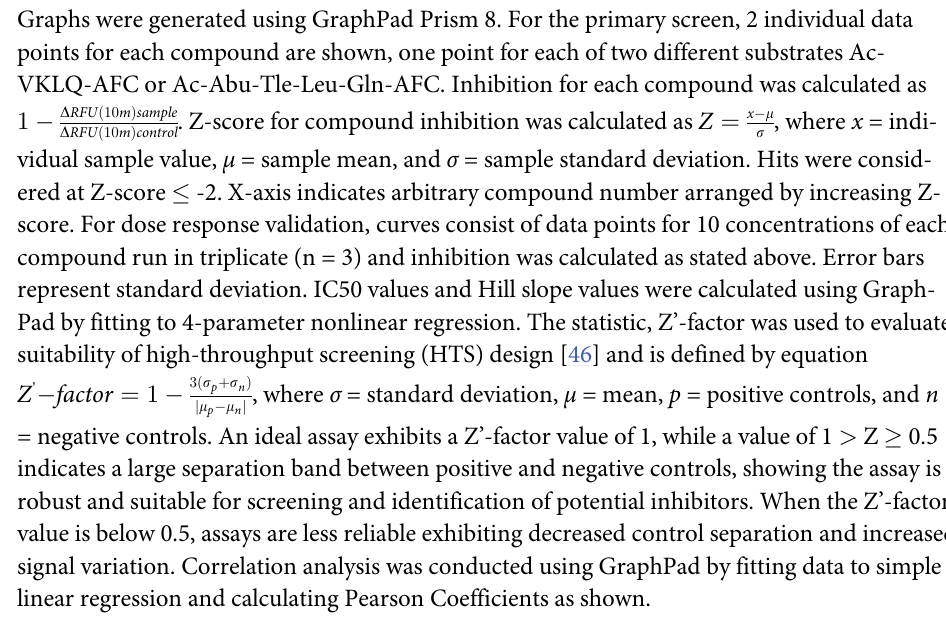
S1 Fig. Dose response curves for ebselen against Mpro cleavage of substrate Ac-Abu-Tle- Leu-Gln-AFC. S1 Table. Broad Library SDF with docking